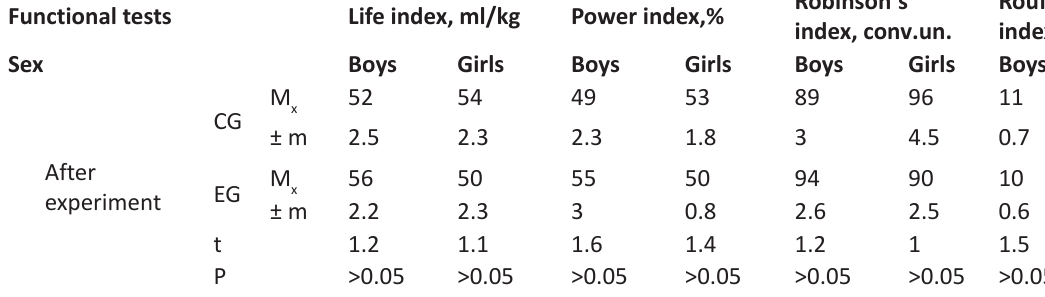
One arm’s pass from shoulder, points